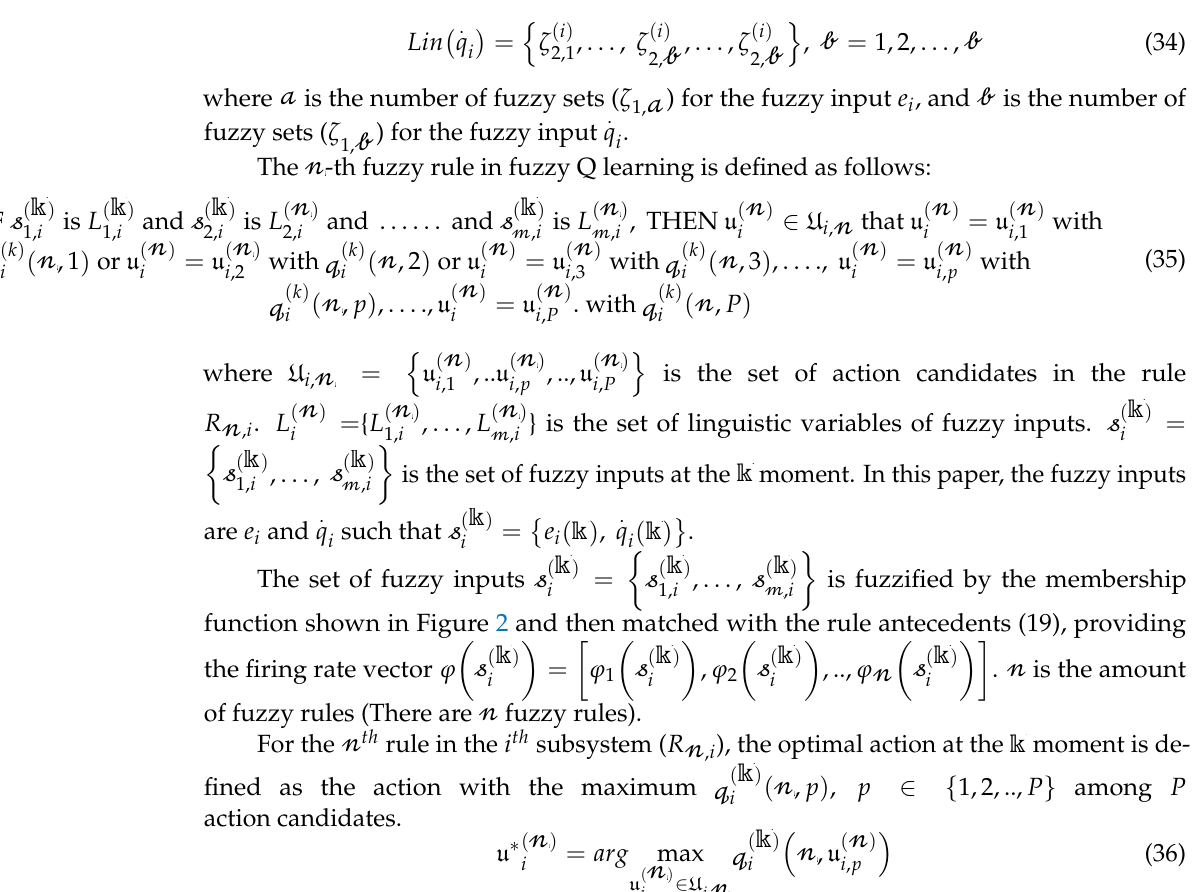
Figure 2. Membership function of fuzzy input of the i th subsystem.